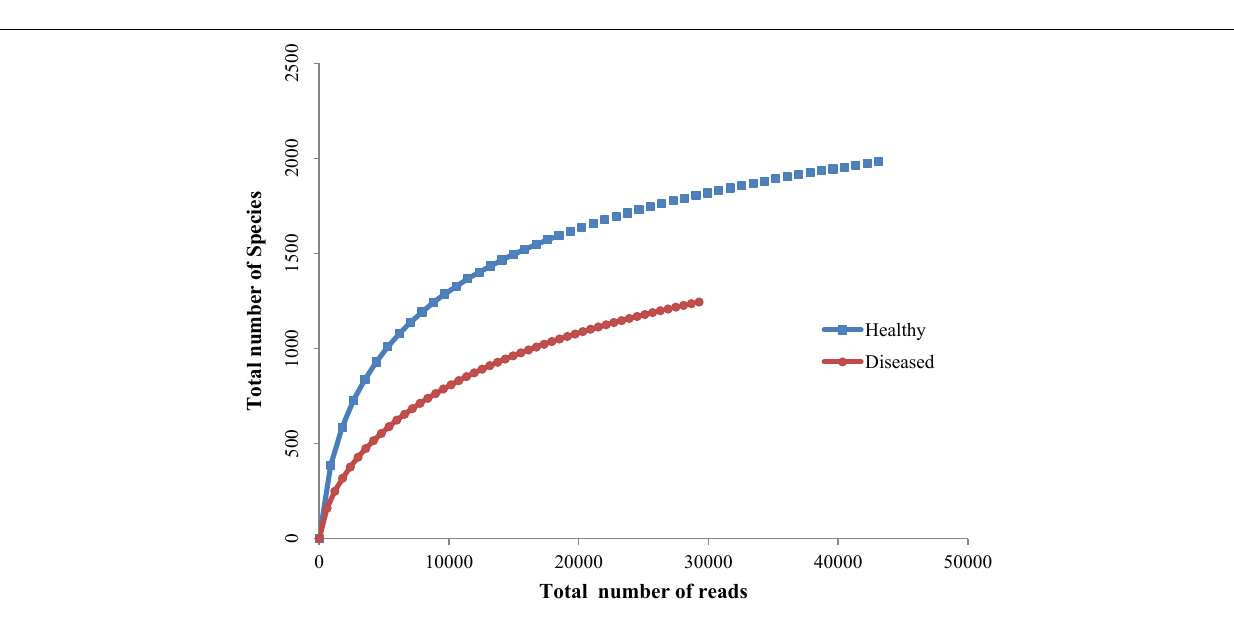
FIGURE 3 | Heatmap analysis showing clustering of the major genera from healthy and SGA samples. Colors represent correlation between samples.